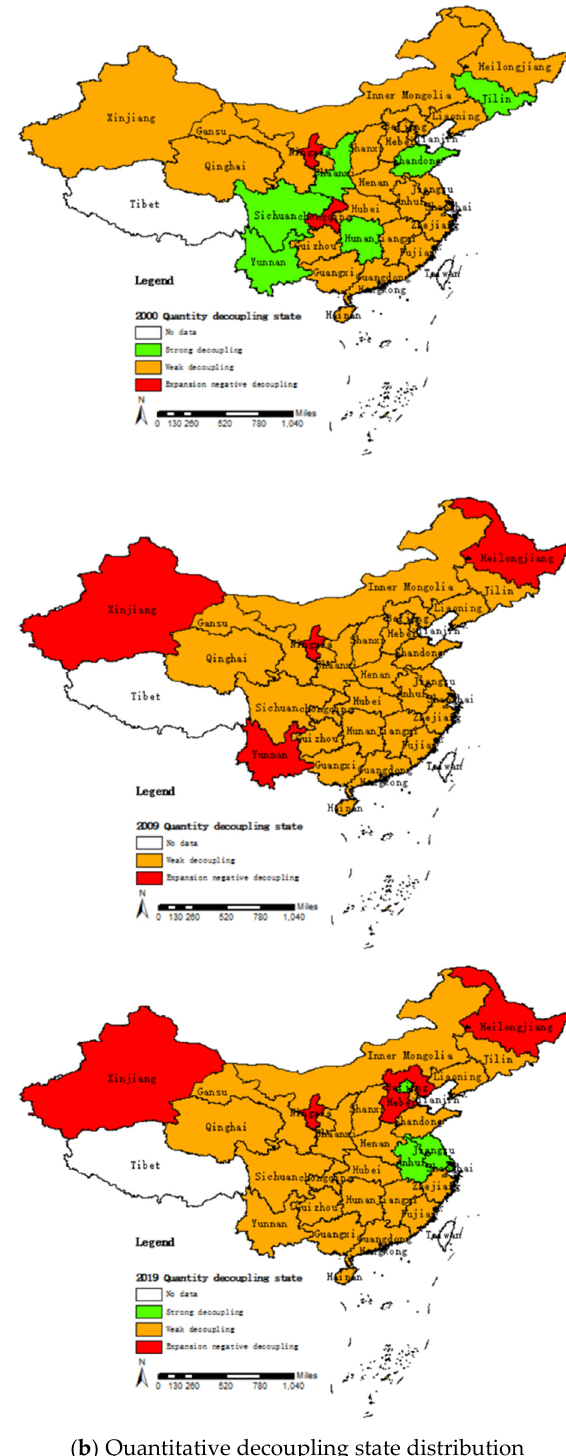
Figure 4. Distribution of decoupling between industrial carbon emissions and industrial economic growth in various provinces of China.